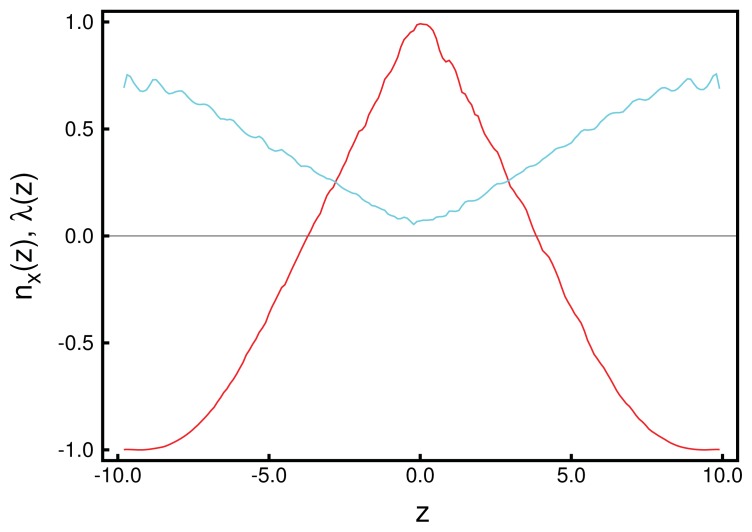
As Figure 1, but for nx (z) (
) and λ (z) (
) and ɛ3 = 0.24.